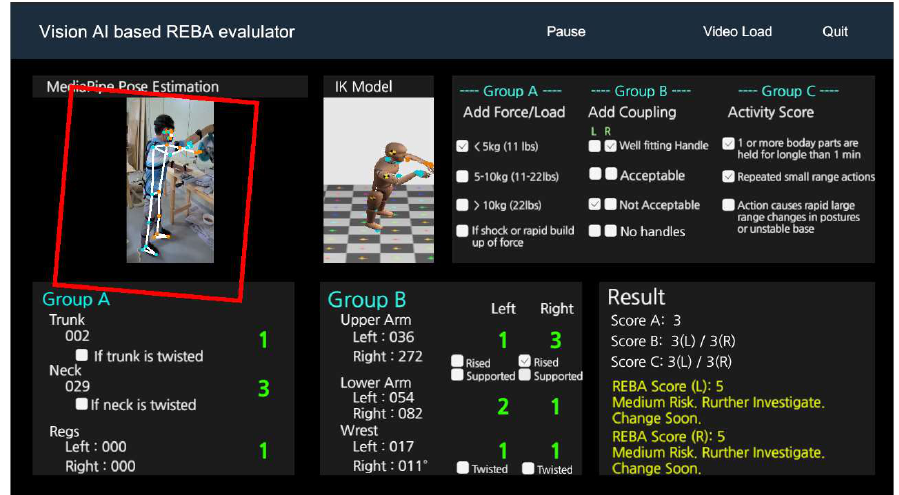
Figure 29. Evaluation of circular saw working